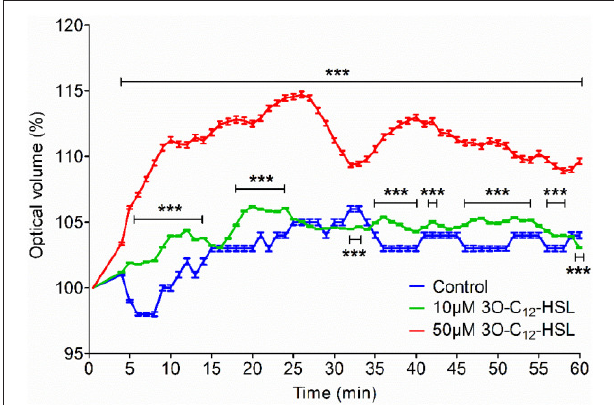
FIGURE 2 | Volume changes in 3O-C 12 -HSL-stimulated macrophages analyzed by holographic 3D imaging. Macrophages were treated with 10 and 50 µ M 3O-C 12 -HSL, or 0.02% DMSO as a vehicle control (Control) and a time-lapse video was recorded using the HoloMonitor M4. Quantification of optical volume shown as a percent (%) of change. Values represent the moving average of the mean ± SE based on 4 independent experiments from 4 different donors and 120–300 cells for each condition. Significant differences were analyzed by two-way ANOVA and Bonferroni’s post-test and are indicated with *** when P < 0.001 compared to control.